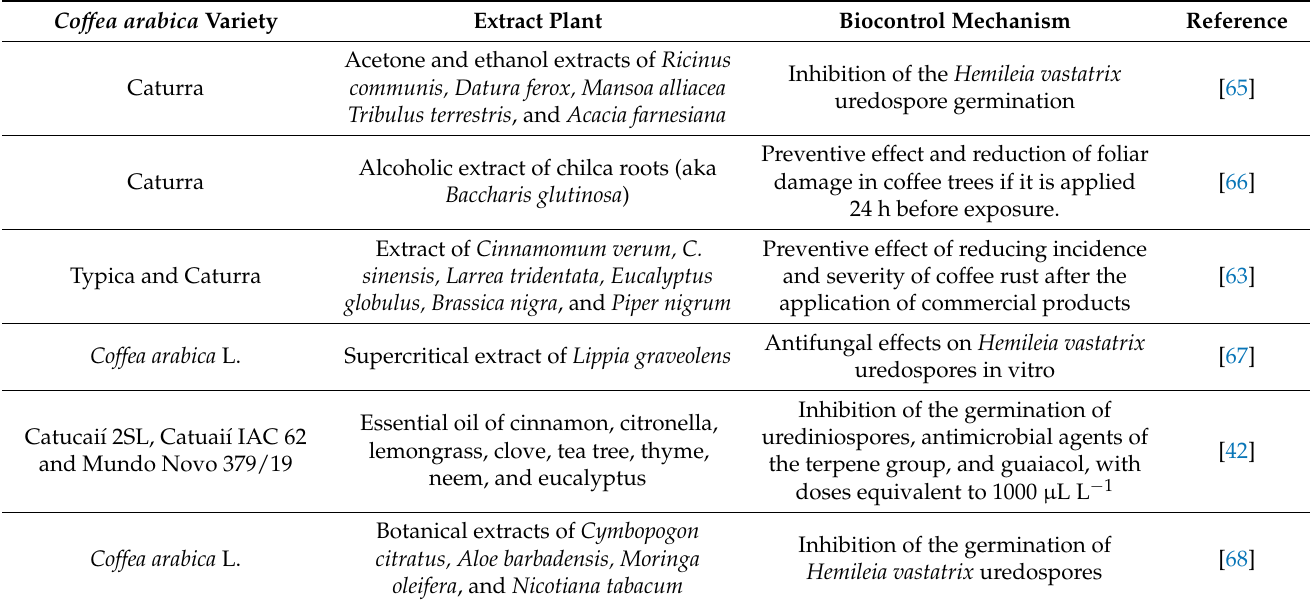
Table 1. Compilation of plant extracts with activity against Hemileia vastatrix used in different varieties of Coffea arabica